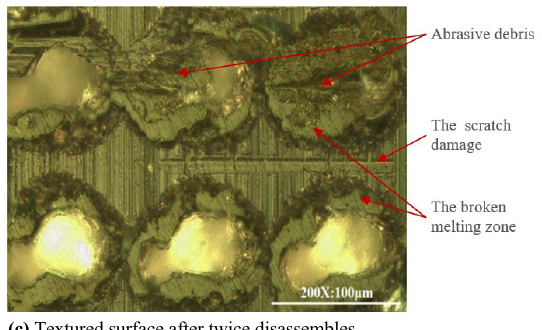
age evaluation value ( Q ) of the excellent textured surface is 0.25, which is much smaller than that of the non-textured surface. reduce disassembly damage is because of its out- standing particles collection capacity and the low probability of damage formation and evolution on the part of surface without pits. The particles collec- tion capacity is mainly affected by two aspects: the total particle collection capacity of textured surface and the effective collection size of single texture pit.